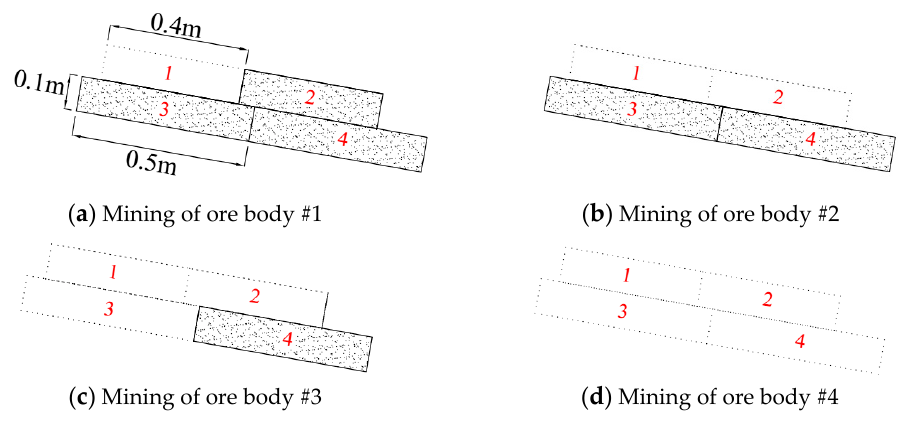
Figure 6. Illustration of the mining process.